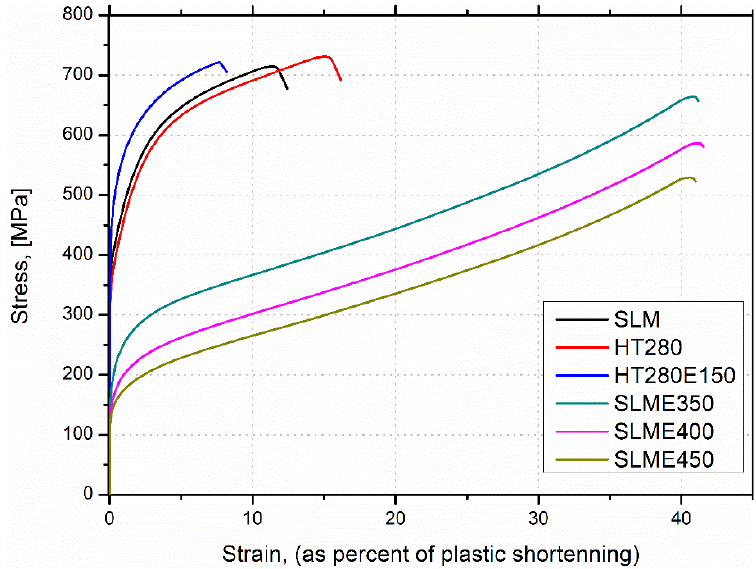
Figure 10. Compressive test plots of studied samples.